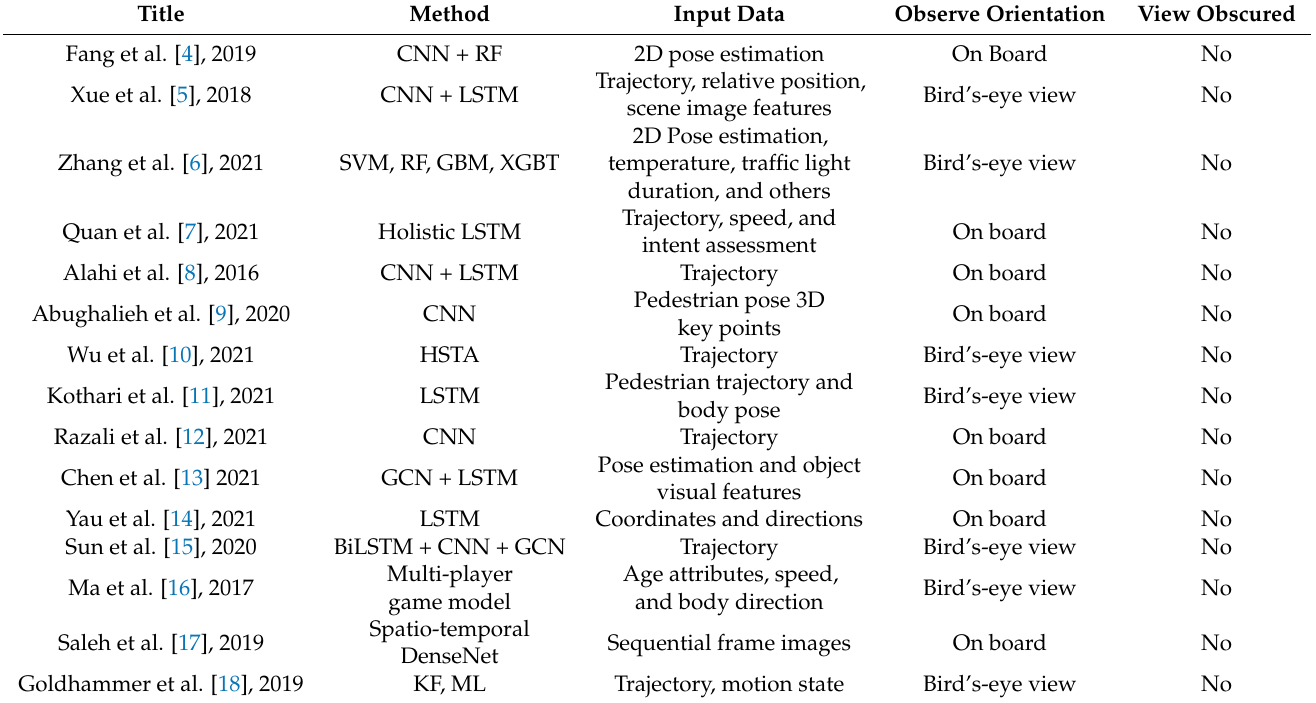
Table 1. Literature on pedestrian intention